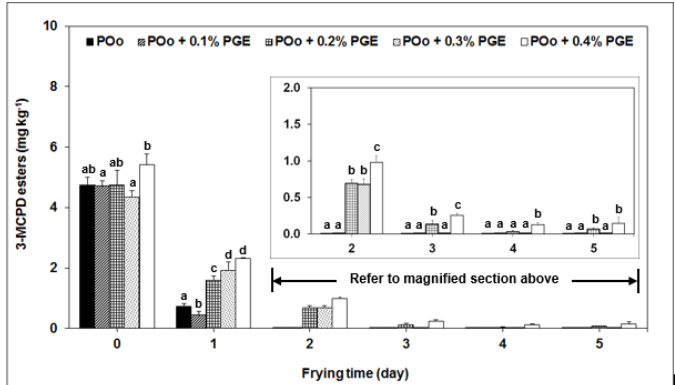
Figure 1. Degradation of 3-MCPD esters in palm olein (Poo) added with polyglycerol fatty acid esters (PGE) during repeated frying. The 3-MCPD esters for frying times between Day-2 and Day-5 can be referred to the magnified section to improve clarity. One-way analysis of variance (ANOVA) was used to indicate the significant difference between the control experiment (POo without PGE) and each frying interval ( p < 0.05), as shown by different lowercase letters.